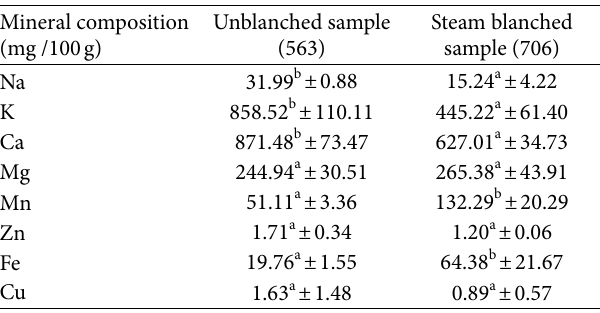
Table 8: Mineral concentrations of unblanched and steam blanched M. oleifera leaves dried at